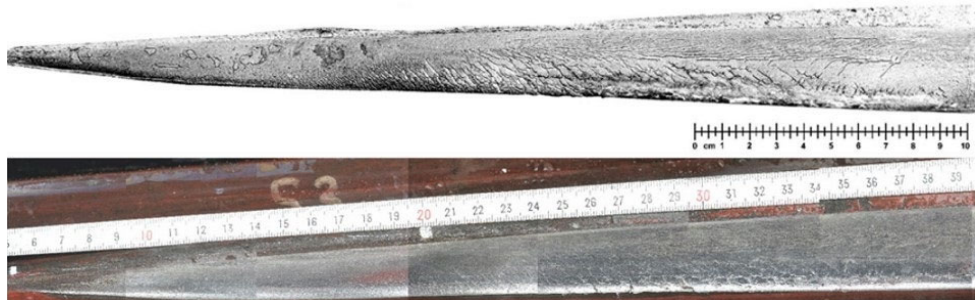
Figure 4. Magnetic particle inspection (above) and camera (below) images of the rolling surface on a frog nose after 33 Mt